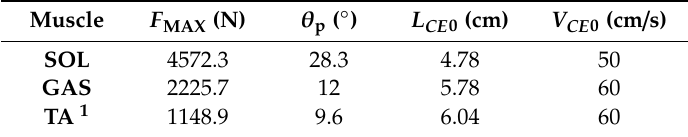
Table 5. Musculoskeletal model parameters of subject B.